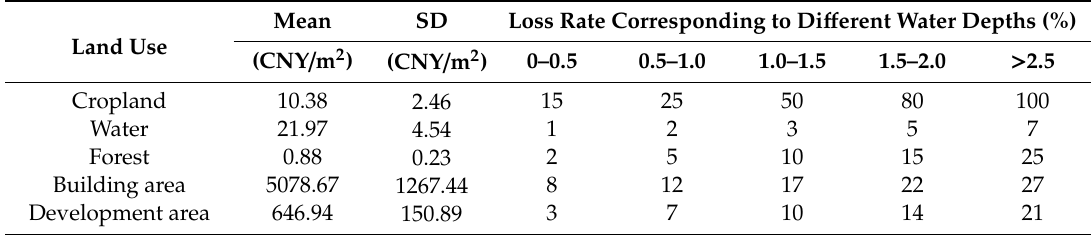
Table 1. Unit area value of each land use type and the loss rates corresponding to di ff erent water depths. Land